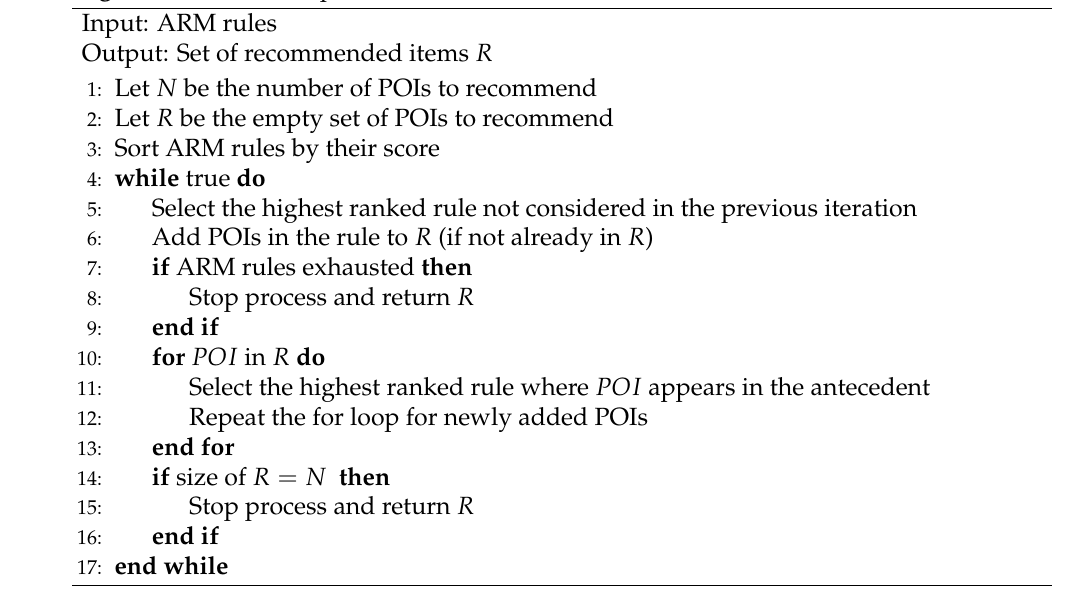
Algorithm 3 Selection